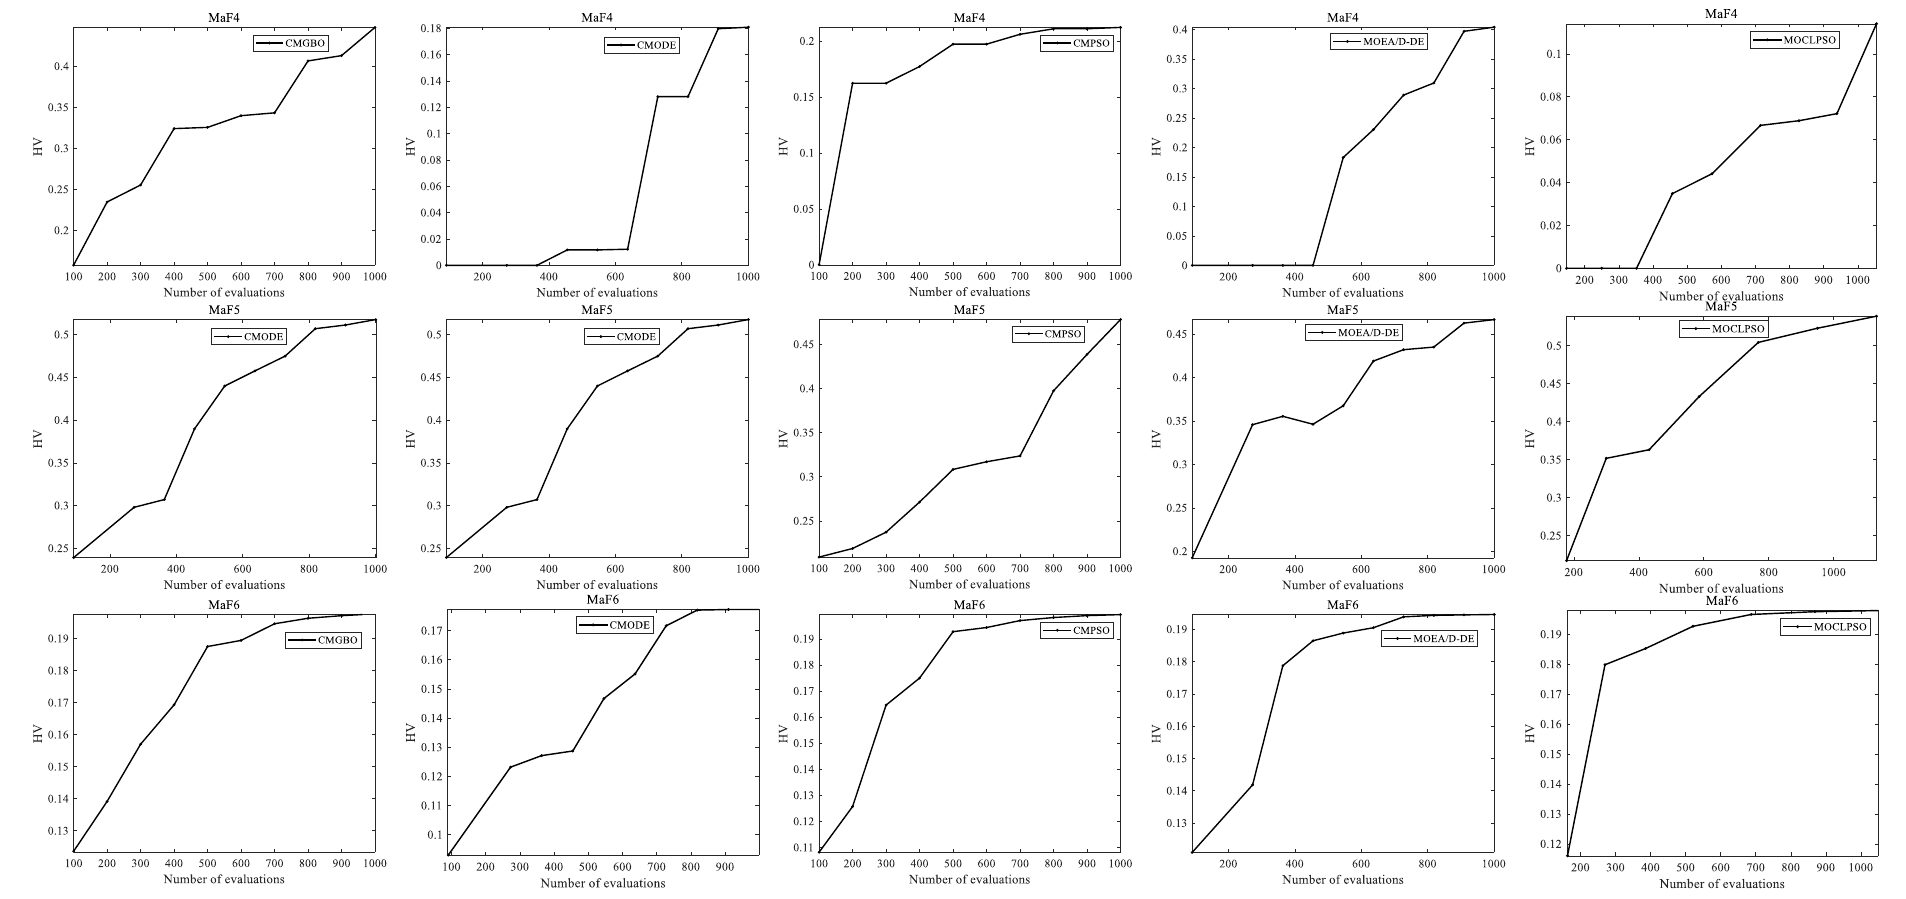
Figure 10. HV metric characteristics of MaFs obtained by each algorithm.